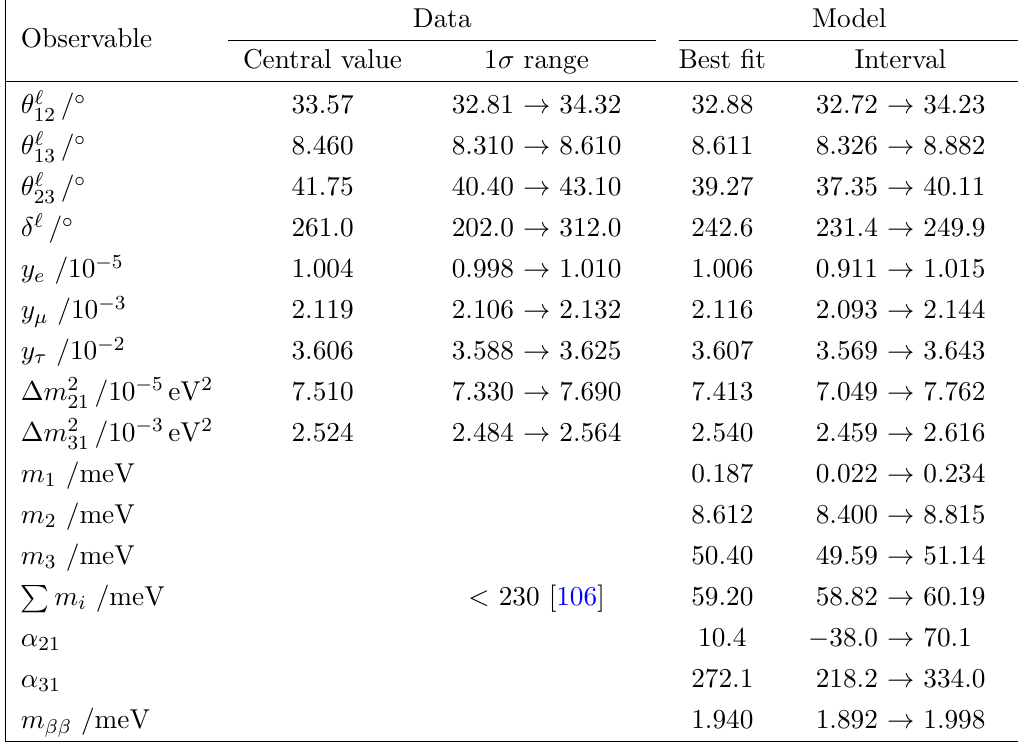
Table 7 . Model predictions in the lepton sector, at the GUT scale. We set tan (cid:12) =5, M SUSY =1 TeV